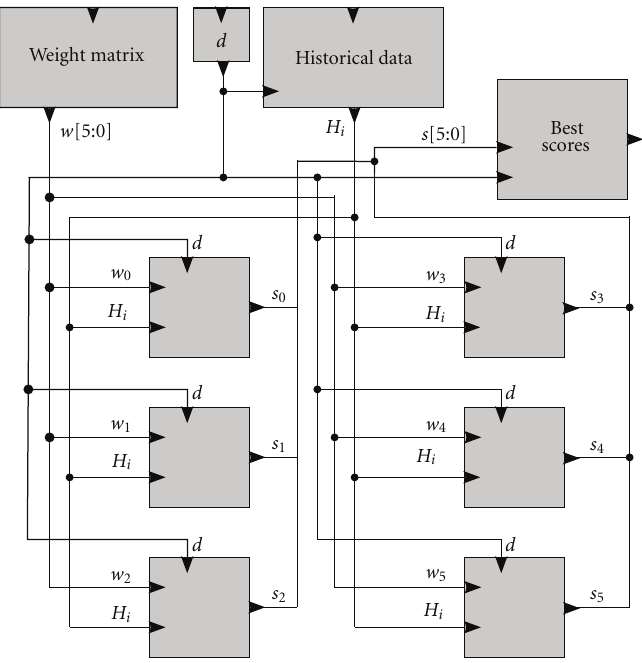
Figure 7: Outline of the processor